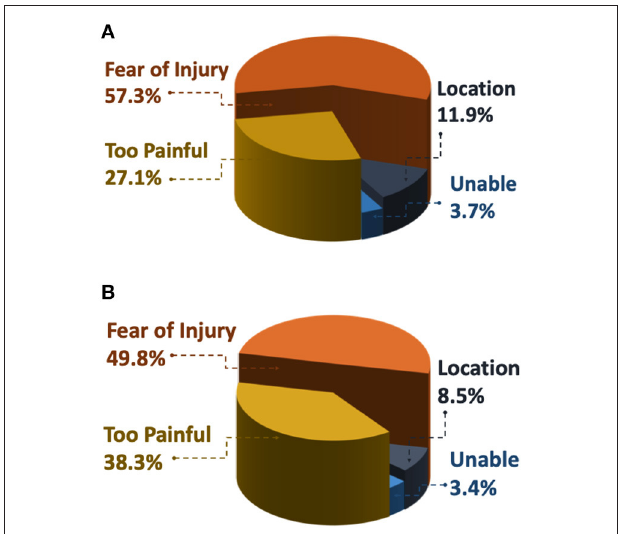
FIGURE 7 | Frequency of reasons why respondents were not willing to do (A) three single leg heel raises and/or (B) three single leg hops. Respondents who choose not to perform the activity were then asked to select why from the following options: Fear of Injury: “I’m afraid I would hurt myself if I did this exercise,” Too Painful: “It would be too painful to do this exercise,” Location: “I am not in a location where I can try this exercise,” Unable: “I am unable to do this exercise on my painful